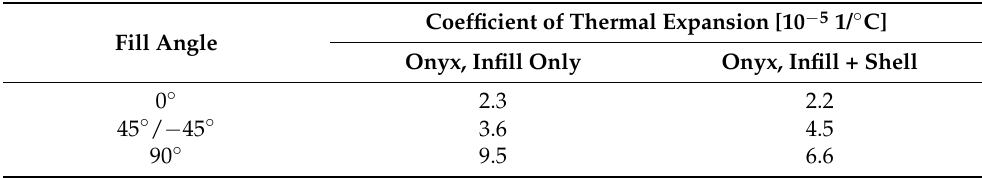
Table 3. Coefficient of thermal expansion values of Onyx with and without shells. All samples printed in the XY orientation.